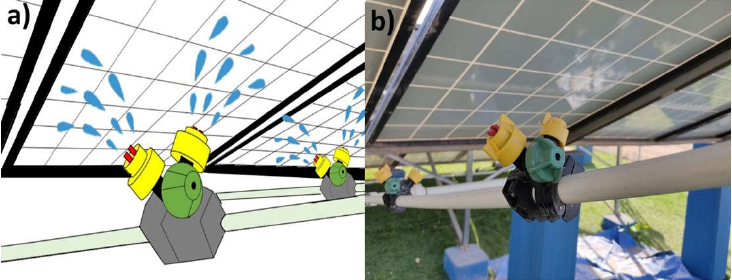
Figure 2. ( a ) Spreading cooling system of the PV modules and ( b ) photograph of the cooling sys-